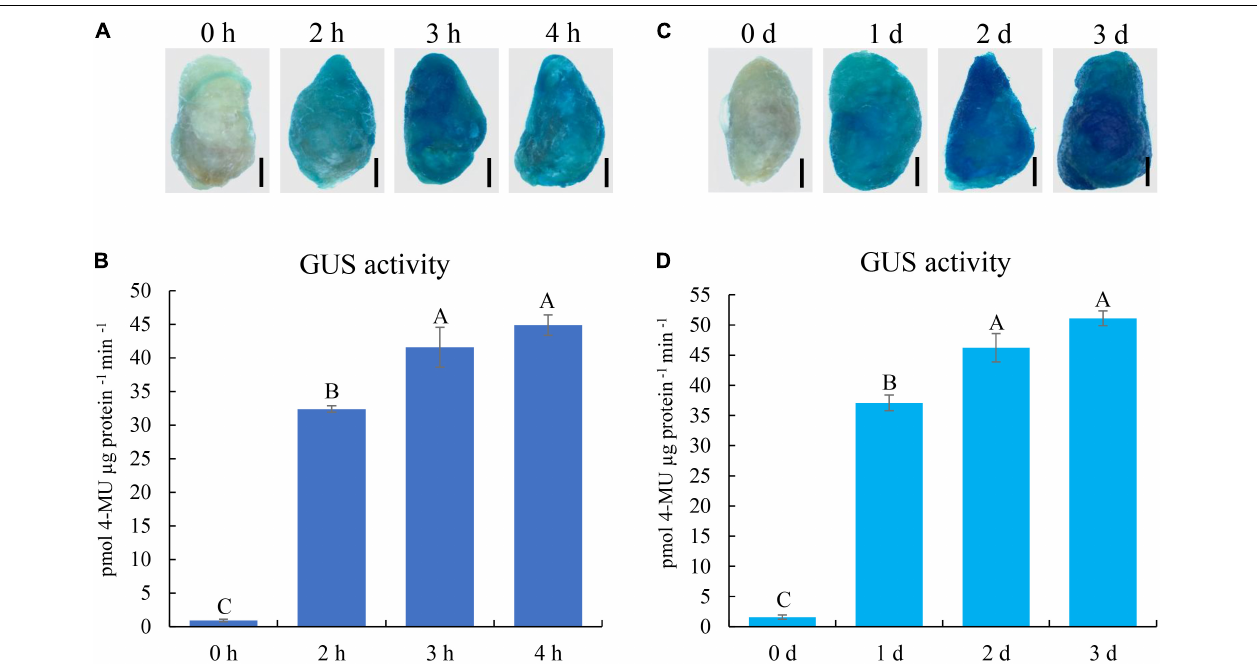
FIGURE 3 | GUS expression analyses of 35S::GUS construct in cotton fibers under different transformation conditions. (A) GUS staining of fibers under different infection times with Agrobacterium . (B) GUS activity of cotton fibers infected with Agrobacterium containing 35S::GUS construct under different infection times. (C) GUS staining of fibers under different incubation times after Agrobacterium infection. (D) GUS activity of cotton fibers under different incubation times following Agrobacterium infection. The black line indicates 2 mm in (A,C) . Error bars indicate SD. Different letters indicate significant differences (Turkey’s test; P < 0.01). h, hour; d, day. Fibers at 20 DPA were used for